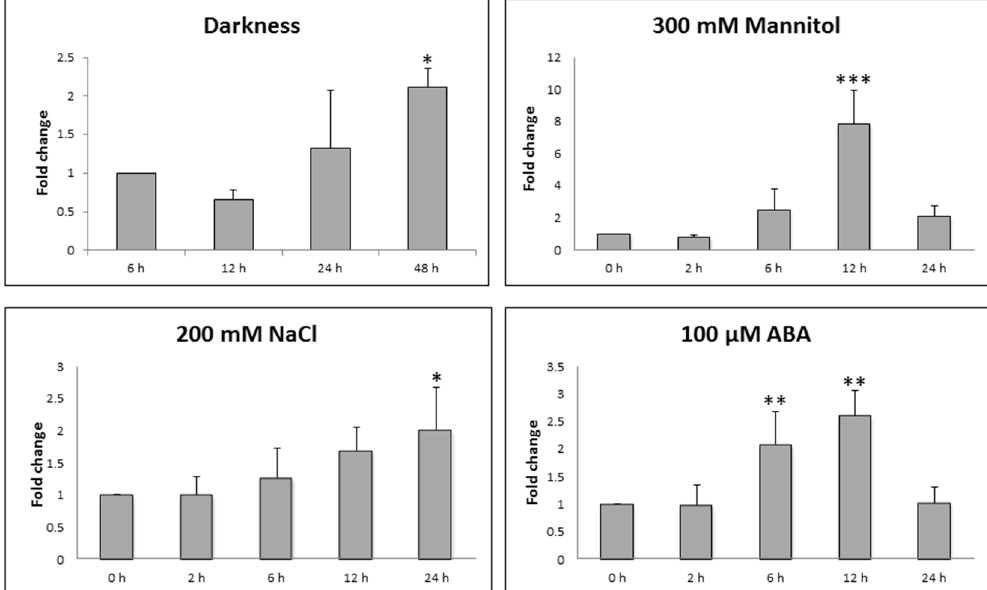
Figure 1. Changes in Ser/Thr/Tyr kinase isoform 46 (STY46) transcripts in wildtype plants (Col-0) under stress. The transcript level of STY46 at 0 h was set as 1. The Y-axis indicates the fold change of STY46 mRNA at different time-points compared to 0 h. Arabidopsis Col-0 plants were treated with 300 mM mannitol, 200 mM NaCl, and 100 µM ABA at 0 h (the beginning of day), 6 h (midday), 12 h (end of day), and 24 h (end of day), respectively. For darkness treatments, the Col-0 plants were exposed to 24 h extended dark (48 h). The asterisks indicate that there is statistically significant difference of transcripts level in stress-treated plants compared with 0 h (‘*’, 0.01 < p < 0.05; ‘**’, 0.001 < p < 0.01; ‘***’, 0 < p < 0.001).